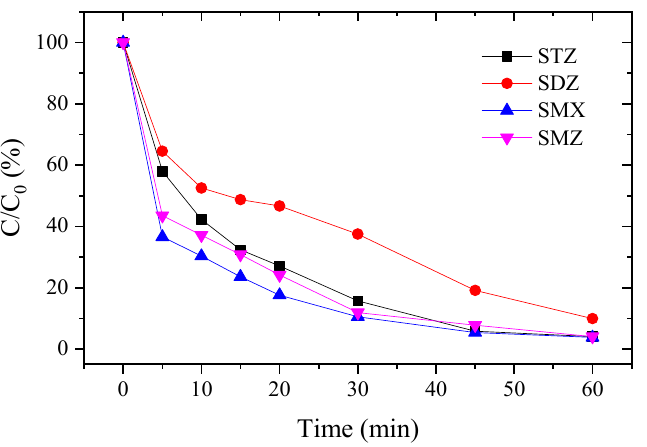
Figure 6. The removal efficiency of different SAs. Conditions: [SAs] = 10 mg/L, [PDS] = 300 mg/L and UV irradiation: 2 mW/cm 2